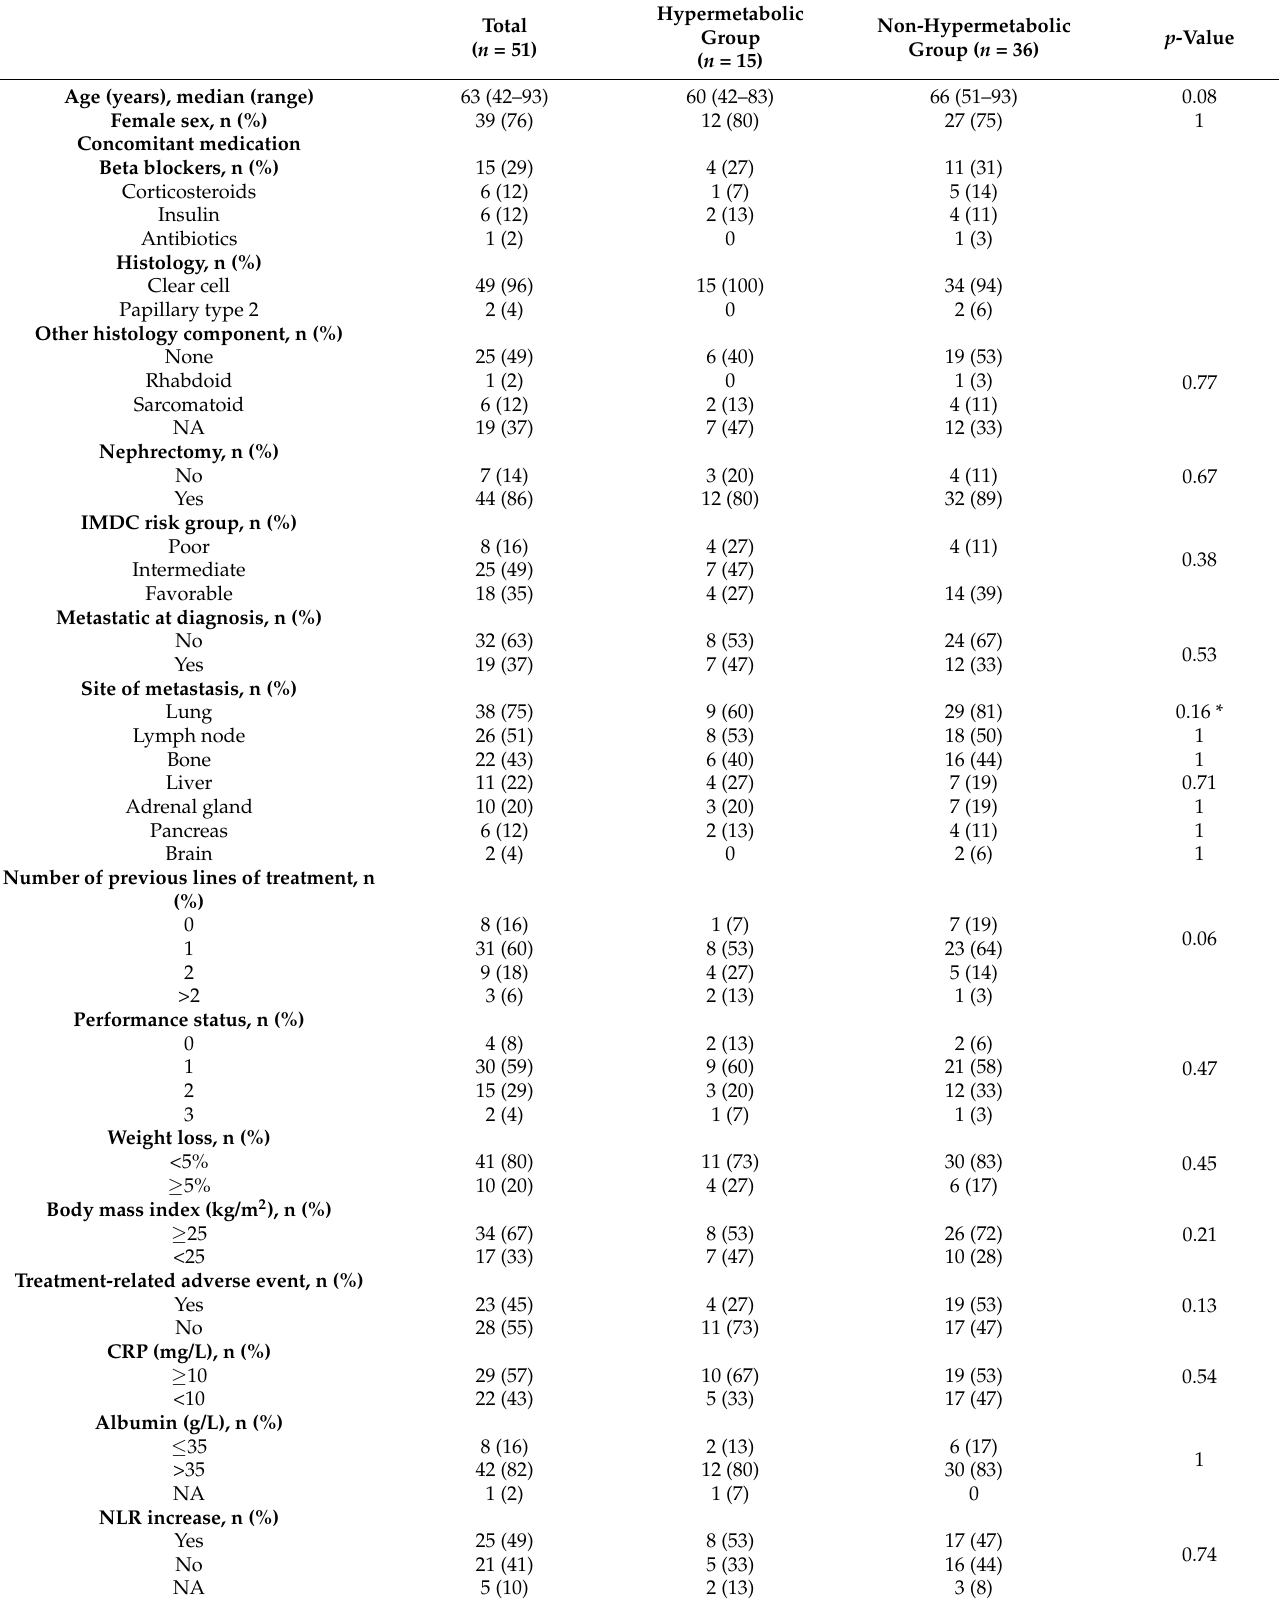
Table 1. Patient